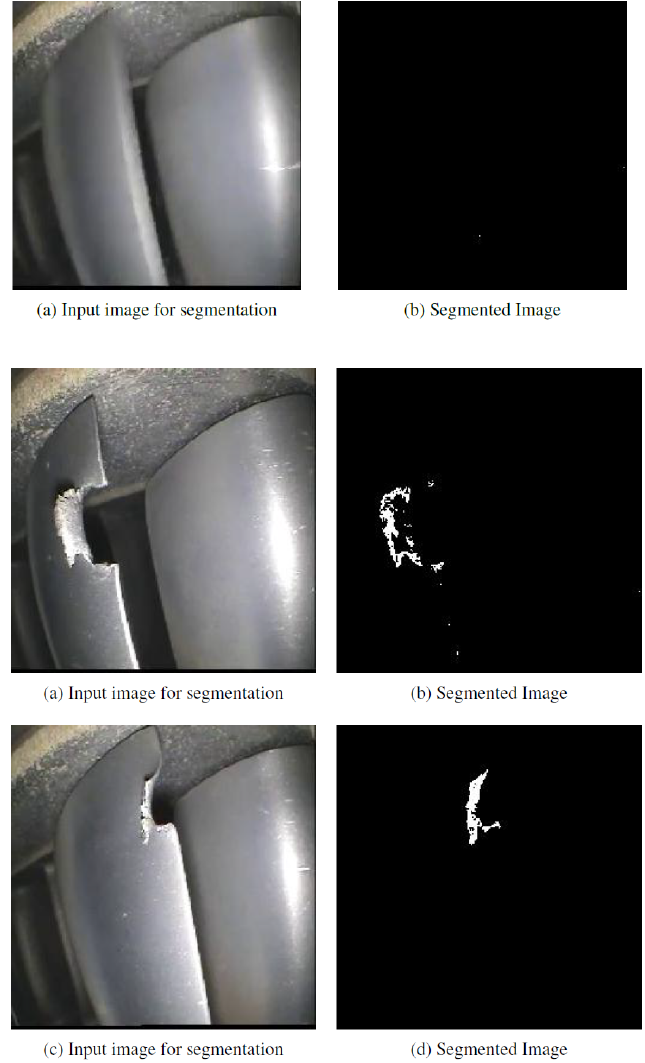
Figure A17. Random Forest segmentation on new images based on transfer